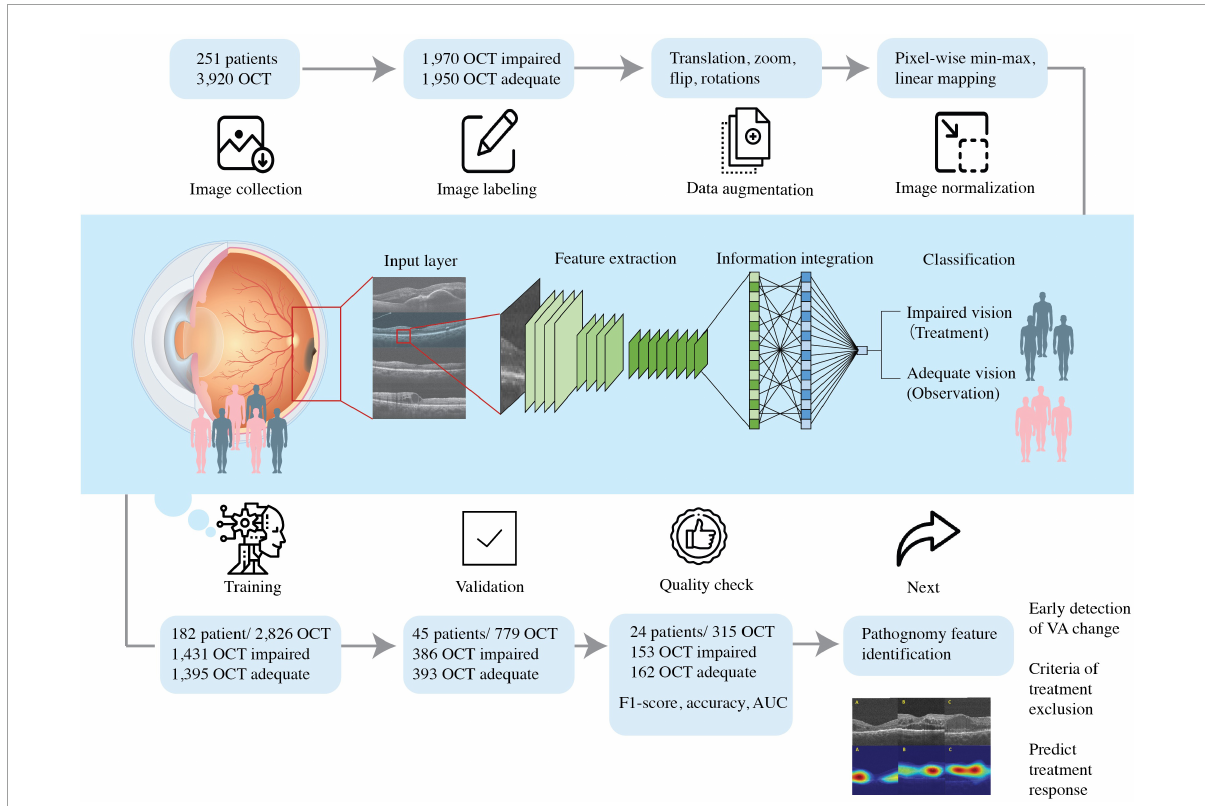
FIGURE2 Schematic diagram showing the flow of this study. We included patients diagnosed with DME with the best- BCVA between 0.05 and 1.50 and collected the optical coherence tomography (OCT) dataset. The dataset was labeled accordingly with BCVA obtained and DME OCT features by experienced ophthalmologists. The pre-processed OCT database trained the convolutional neural network, so the artificial intelligence algorithm could predict VA and guide therapeutic